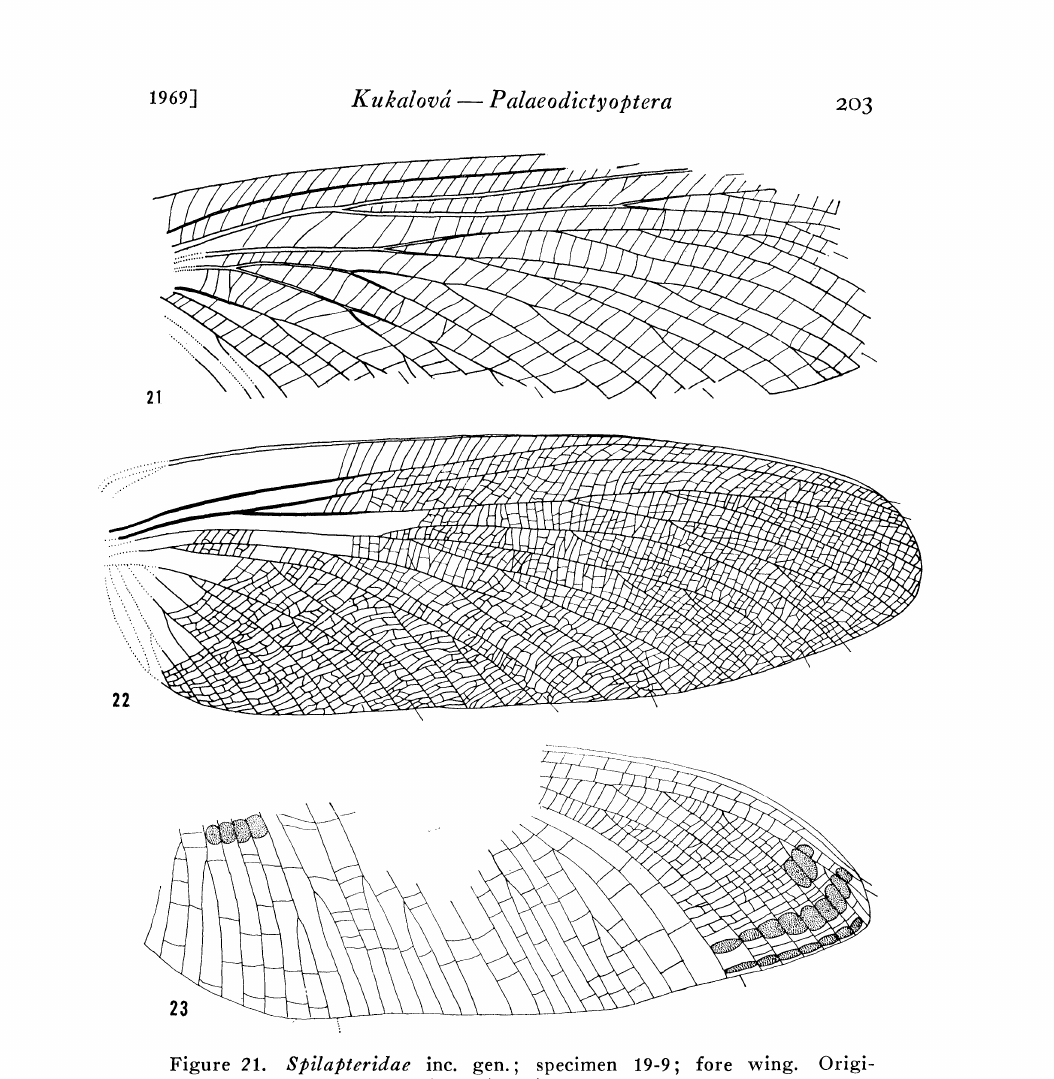
Figure 21. Tpilateridae inc. gen.; specimen 19-9; fore wing. Origi- nally described as Lamrotilia stirrui Brongniart, 1893. Figure 22. F.ouquea lacroixi Brongniart. Originally described as Fouquea comstocki Lameere, 1917. Figure 23. Compsoneura formosa (Brongniart); specimen 19-2; tore wing.